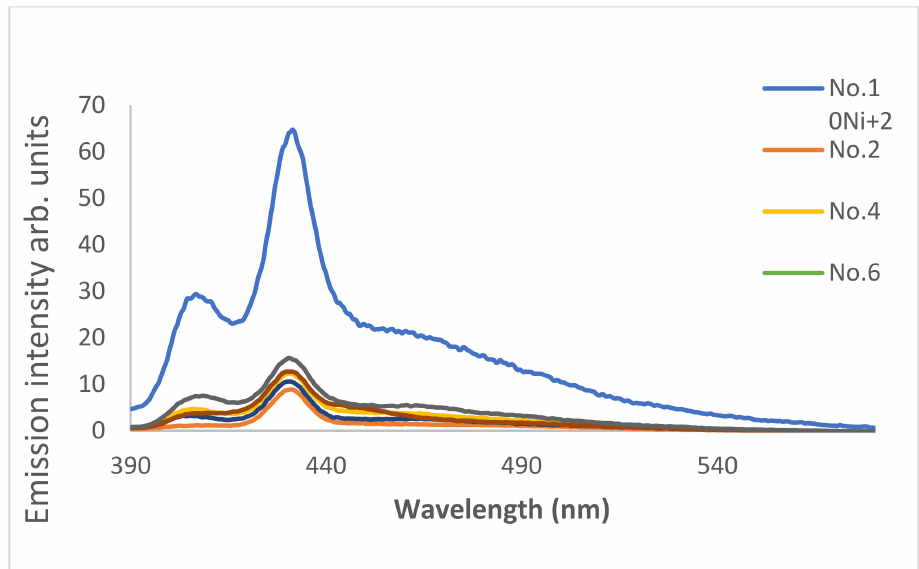
Figure 23. Fluorescence spectra of 7.5 × 10 − 5 M of 2-amino-4-hydroxy-6-(4-hydroxy-2-oxo-2H- chromen-3-yl)nicotinonitrile 4 in an aqueous solvent; decrease in emission intensity at increasing [Ni 2+ ]: 0, 2, 4, 6, 8, 10, 12 µ M, λ ex = 376 nm.